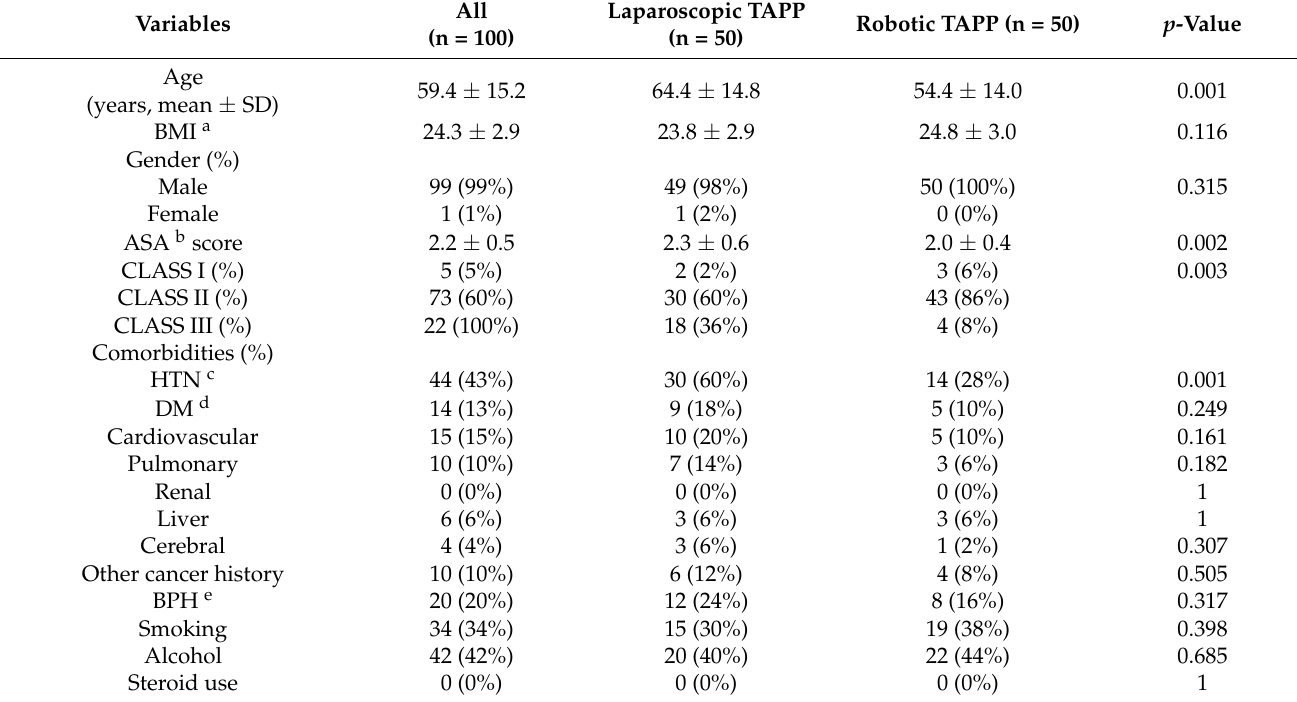
Table 1. Clinical characteristics of hernia